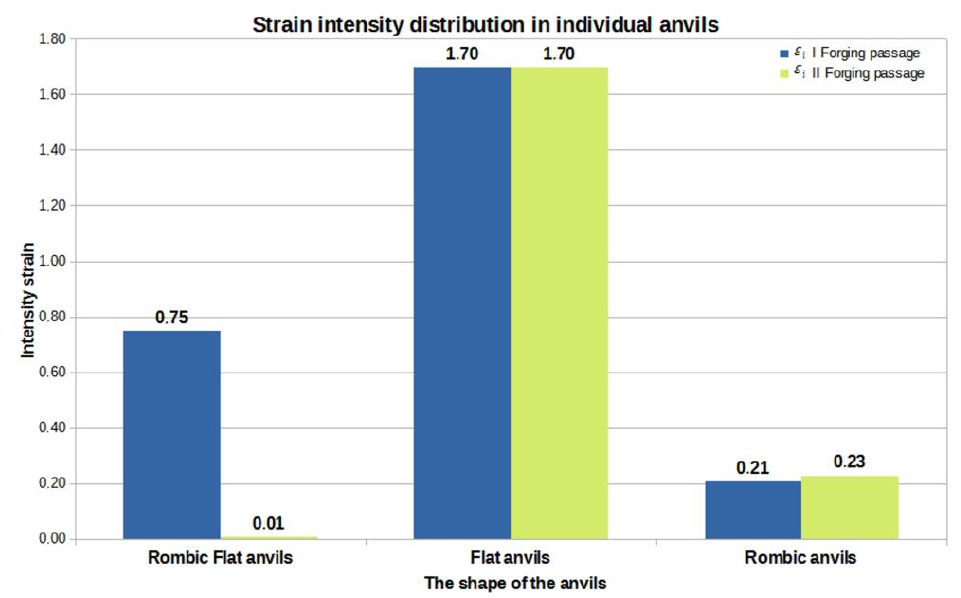
Figure 17. A graph of the arithmetic mean value of the deformation intensity occurring around unwelded discontinuities in relation to individual anvil compositions.